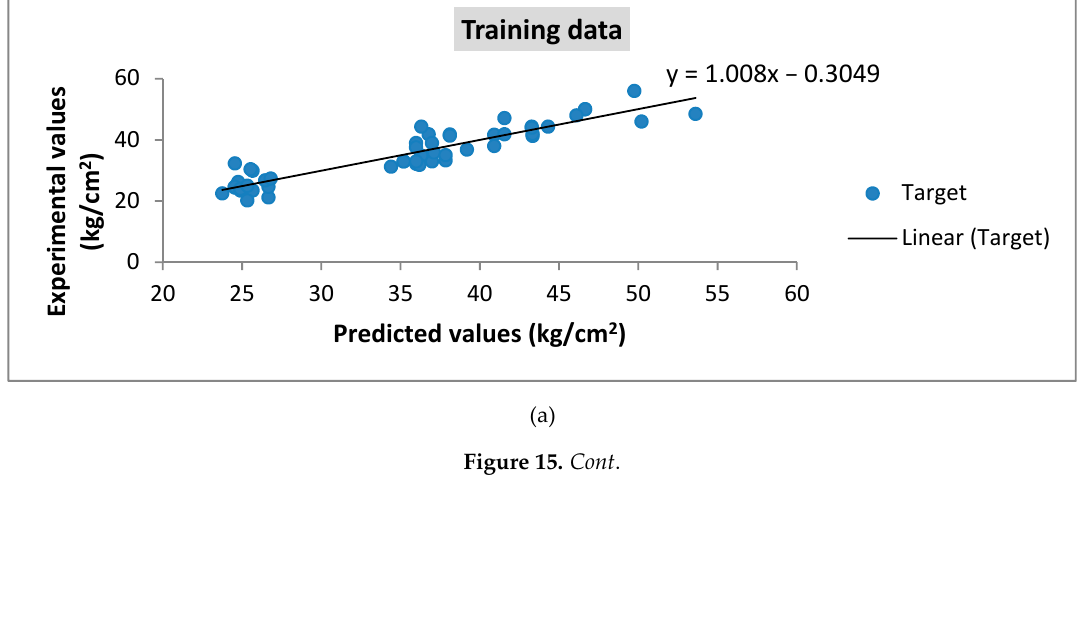
y = 1.008x − 0.3049